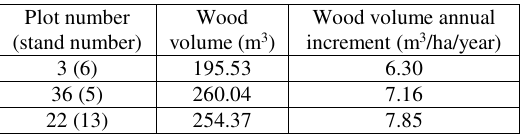
Table 1. Wood volume data from the forest management plan of the